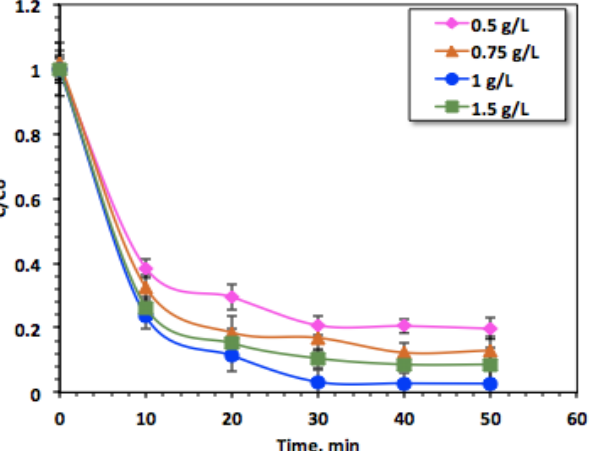
Figure 5. Effect of Montmorillonite catalyst concentration on the photo-Fenton reaction.